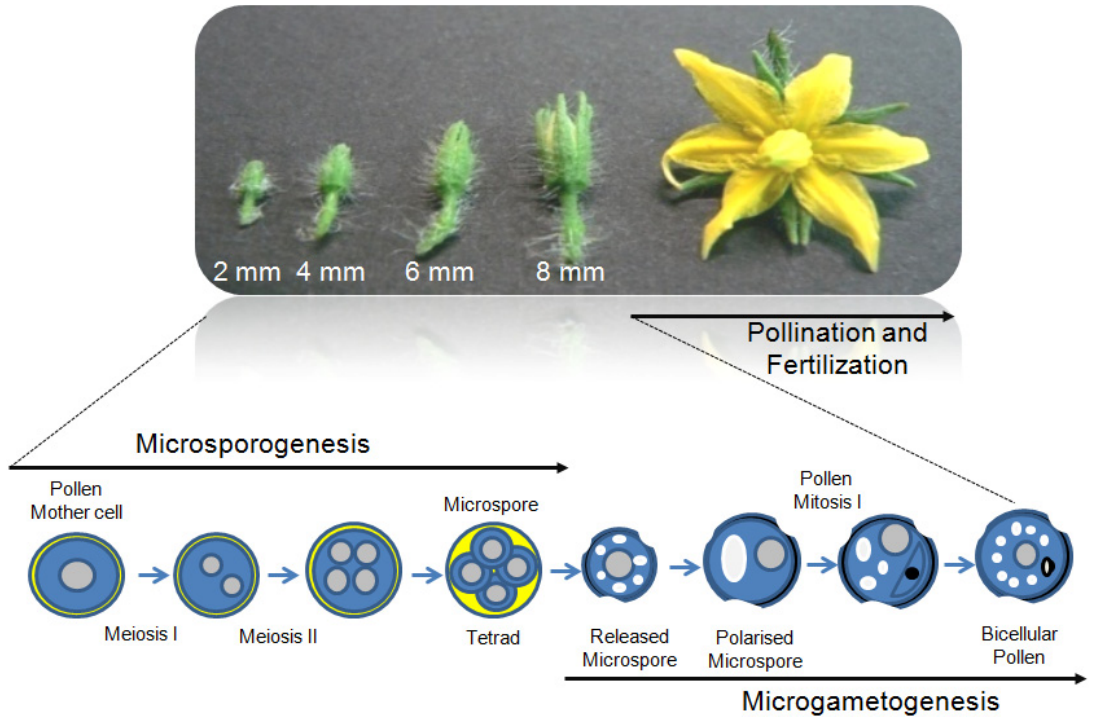
Figure 1. Tomato flower buds at different developmental stages from cv Saladette. Young buds ranging from 2 mm to 8 mm in length correspond to the phases in which microsporogenesis and microgametogenesis processes occur in anthers, while pollination and fertilization take place at anthesis